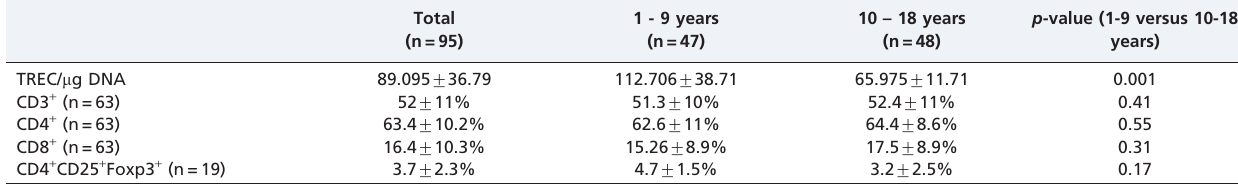
Table 1 - Number of TREC copies/ m g DNA and relative expression of CD3 + , CD4 + , CD8 + T cells and regulatory T cells (CD4 + CD25 + Foxp3 + ) in healthy children and adolescents among different age groups (median ¡ standard deviation).